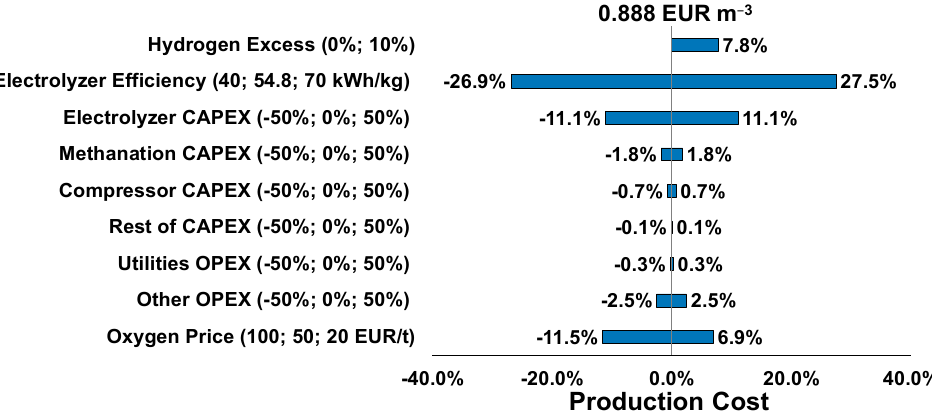
Figure 10. Methane production cost breakdown and effect of electricity price of the NG case.